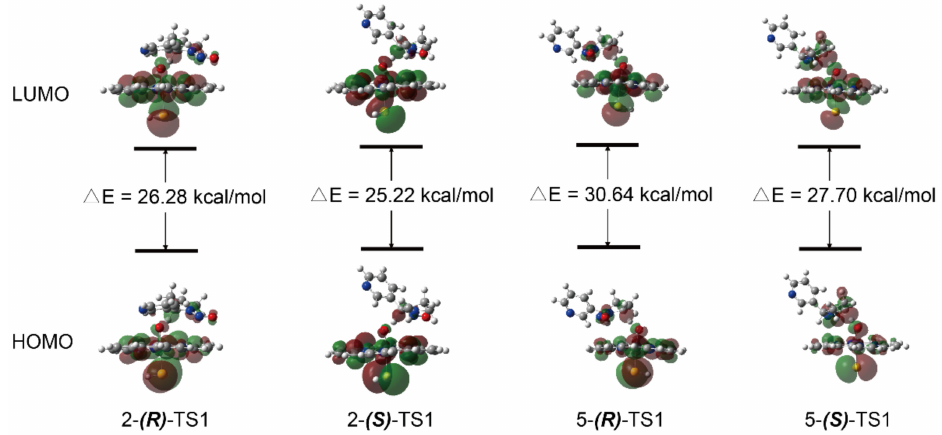
Figure 3. Frontier molecular orbital diagram of four transition states of ( R )-NNN and ( S )-NNN catalyzed by CYP450 Cpd I through 2 (cid:48) - and 5 (cid:48)